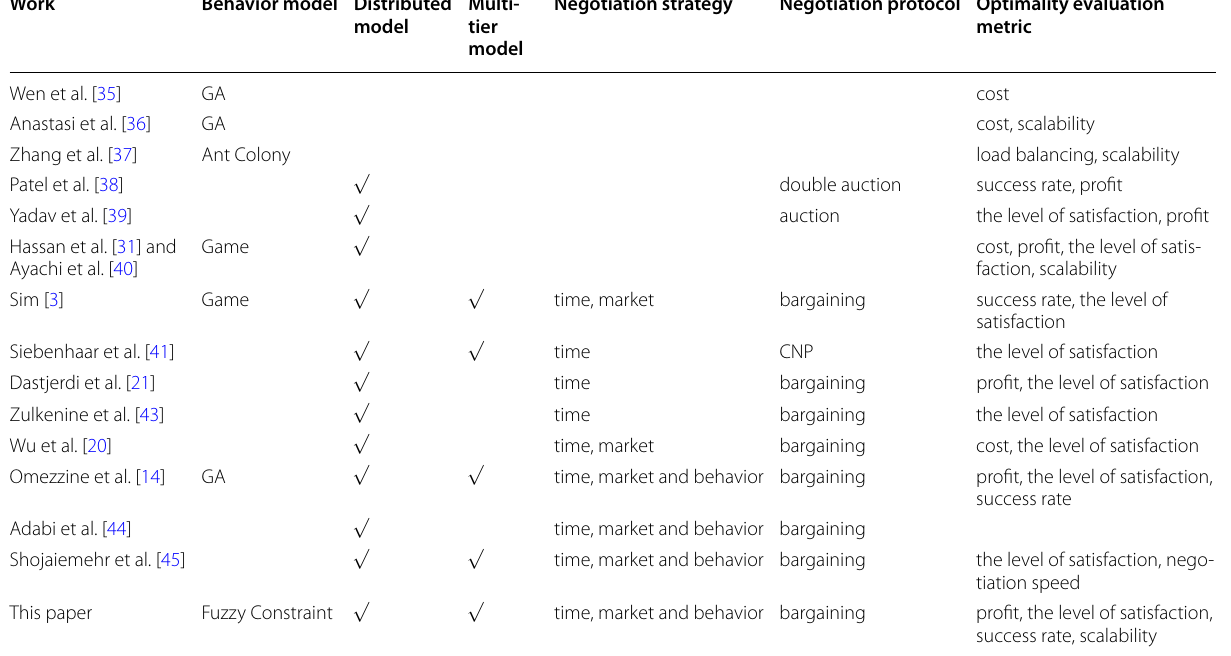
Table 1 Summary of the aforementioned approaches